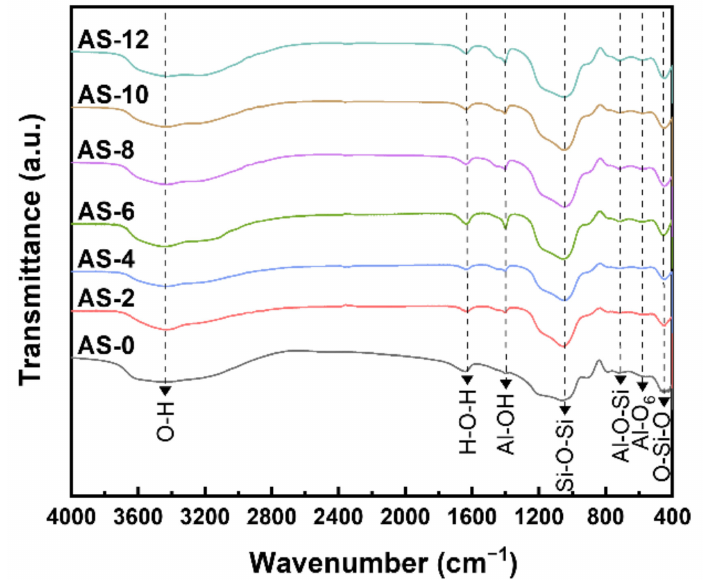
Figure 3. IR spectra of the synthesized aluminum silicate powder with different ammonia